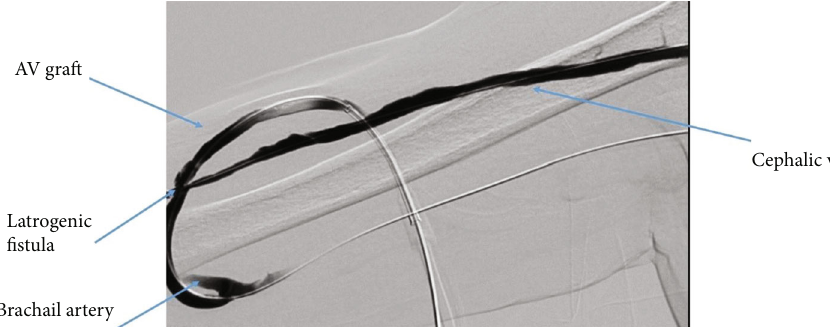
Figure 5: Post cephalic vein thrombectomy/percutaneous angioplasty.